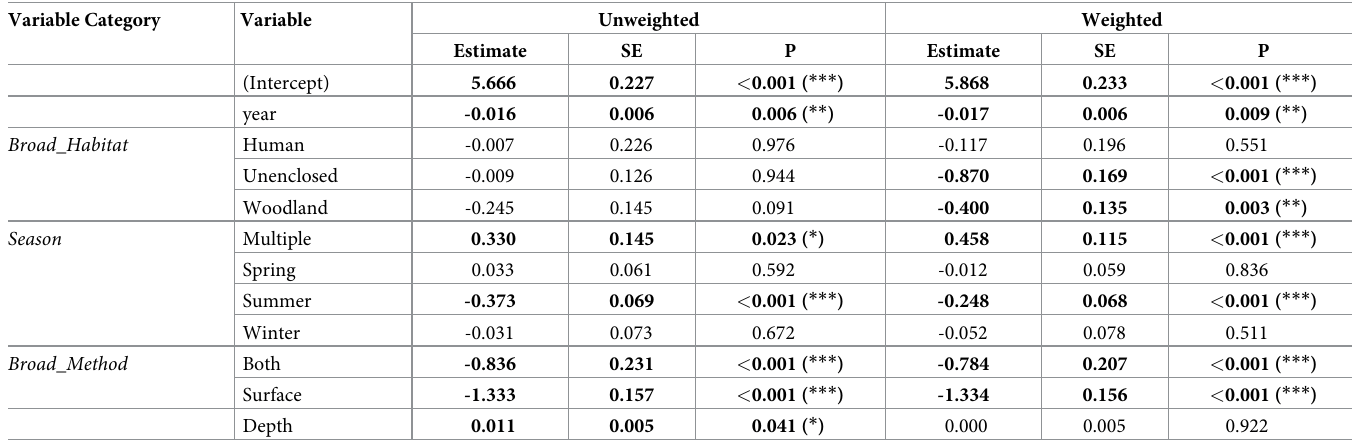
Table 3. Model 1 output of earthworm abundance. Unweighted and weighted (by the natural log of Sample Extent + 1) Model 1 estimates without the interaction, com- pared to the base of Farmland, Autumn and Core (significant estimates are in bold, the stars represent: * < 0.01, ** < 0.001, *** < 0.0001, SE = Standard Error). Variable